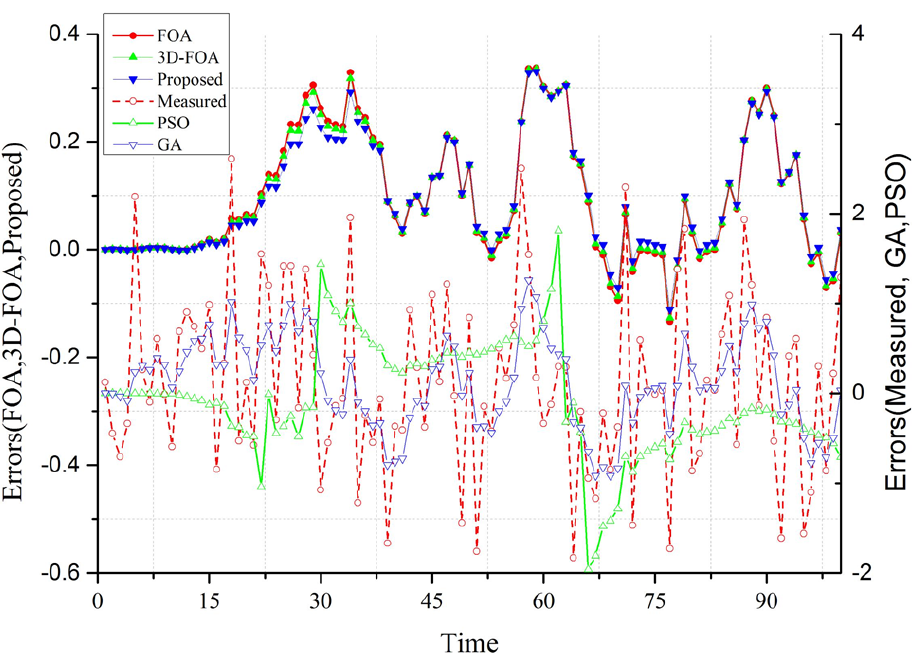
Figure 8. The estimation error of different optimization algorithms.